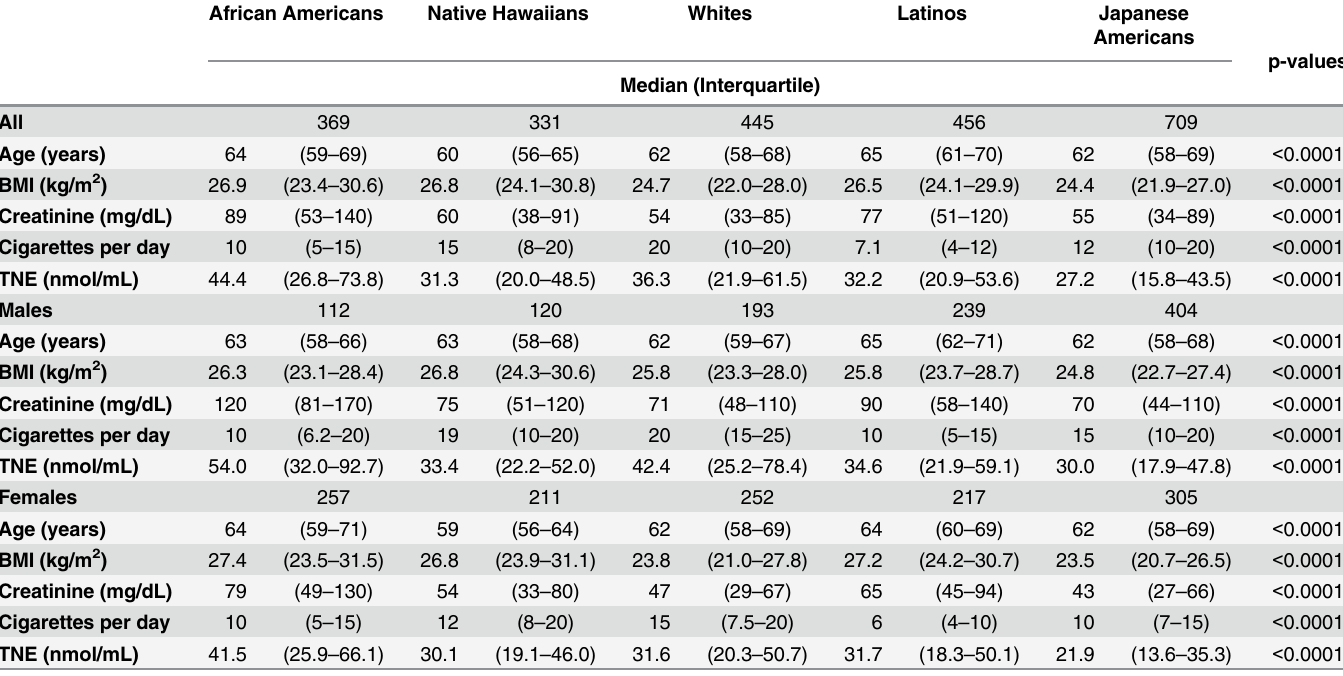
Table 1. Main characteristics of study participants a stratified by race/ethnicity. African Americans